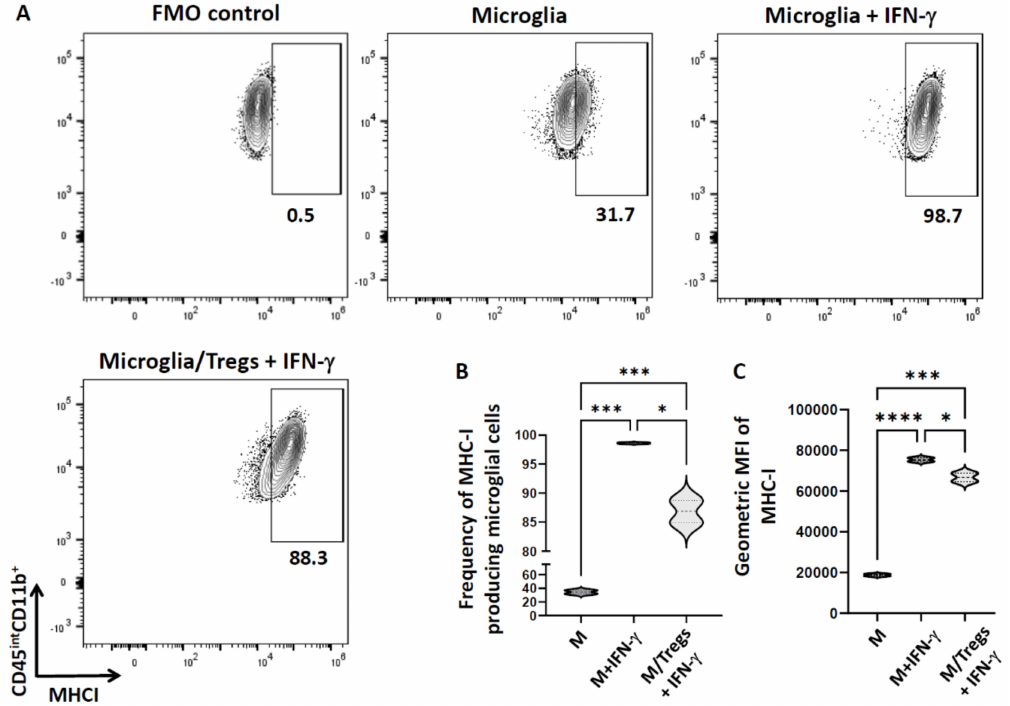
Figure 5. Tregs reduce MHC class I expression on microglial cells. Microglia were incubated with Tregs for 1 h and then co-cultured with IFN- γ (10 ng/mL) overnight, after which cells were harvested and analyzed for the expression of MHC − 1. ( A ) Representative contour plots show expression of MHC − 1 by microglia (CD45 int CD11b + ). ( B ) Violin plot showing the frequency of MHC − 1-producing microglial cells. ( C ) Violin plot showing the geometric MFI of MHC − 1. Data shown are representative of three experiments using 3 wells/group/experiment and expressed as mean ± SE. IL − 2/anti − IL − 2-injected C57BL/6 mice ( n = 4/experiment). **** p < 0.0001, *** p < 0.001, and * p <